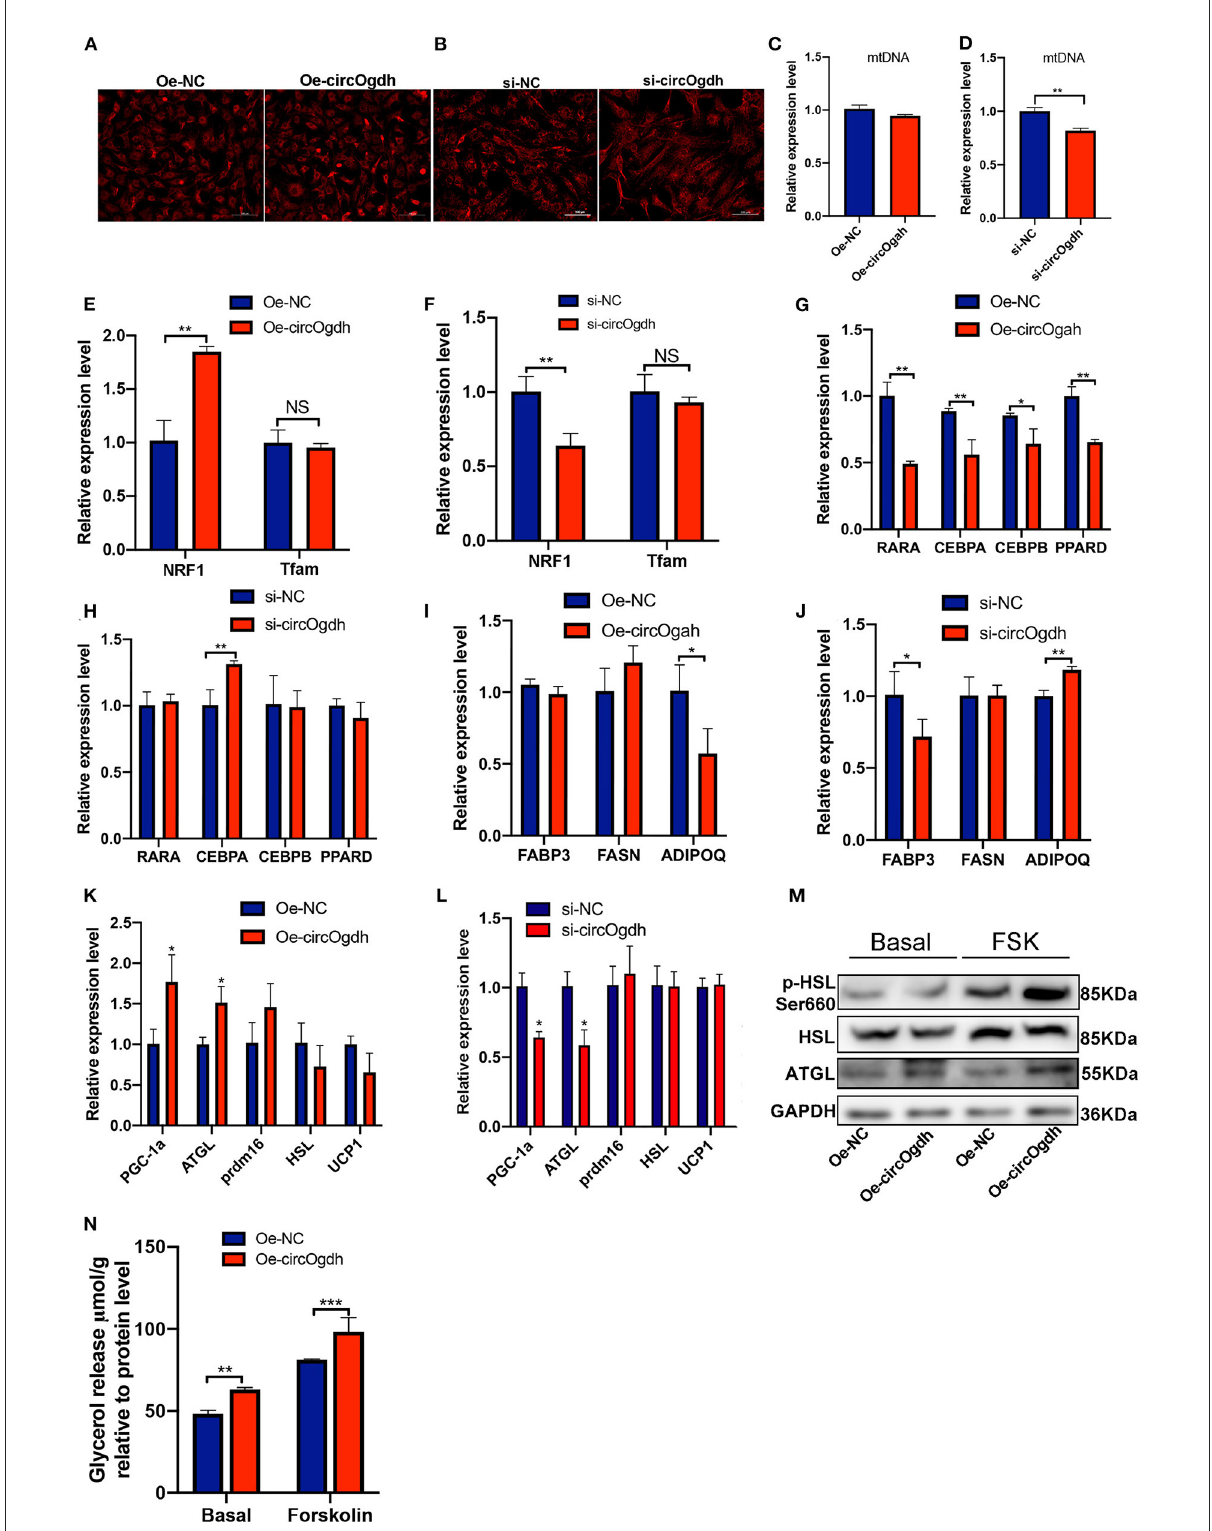
FIGURE8 CircOgdh reduces lipid deposition in brown fat by promoting lipolysis after overexpression or knockdown of circOgdh for 48h, (A,B) Mitochondrial membrane potential was assessed by Mito-Tracker Red staining. Scale bar, 100 µ m. (C,D) Mitochondrial DNA (mtDNA)